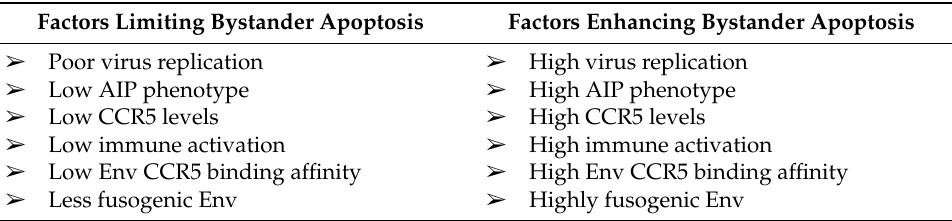
Table 1. Host and viral factors determining differential CD4 loss in HIV infections. Factors Limiting Bystander Apoptosis Factors Enhancing Bystander